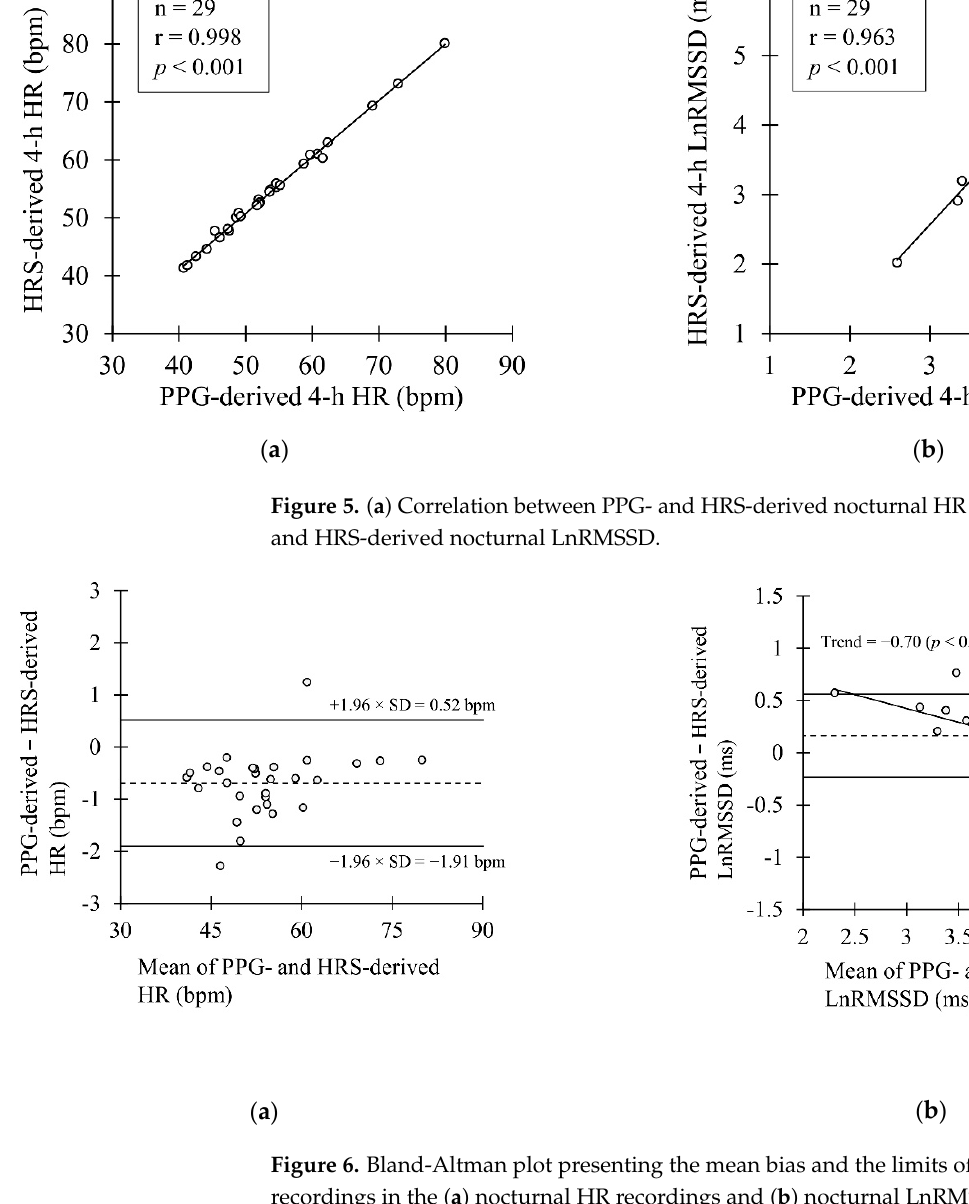
Figure 6. Bland-Altman plot presenting the mean bias and the limits of agreement in the laboratory recordings in the ( a ) nocturnal HR recordings and ( b ) nocturnal LnRMSSD recordings.